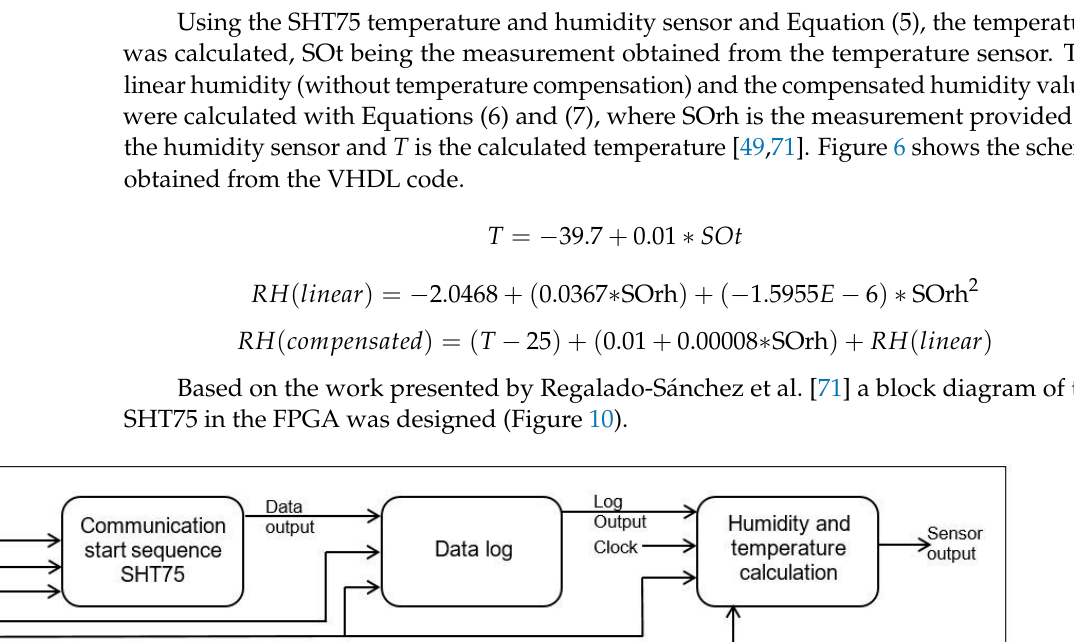
Figure 10. Block diagram of the SHT75 in the FPGA. First, a block was designed in charge of provid- ing the communication start and restart sequence. Subsequently, a state machine, a frequency di- vider module, and a multiplexer were implemented for the data input and output of the FPGA. Figure 11 results from the measurement process developed with the SHT75 relative humidity sensor. In this graph, the SHT75 sensor effectively follows the trend of a com- mercial sensor (UNI-T A12T) [51]. However, there is a point where the commercial sensor